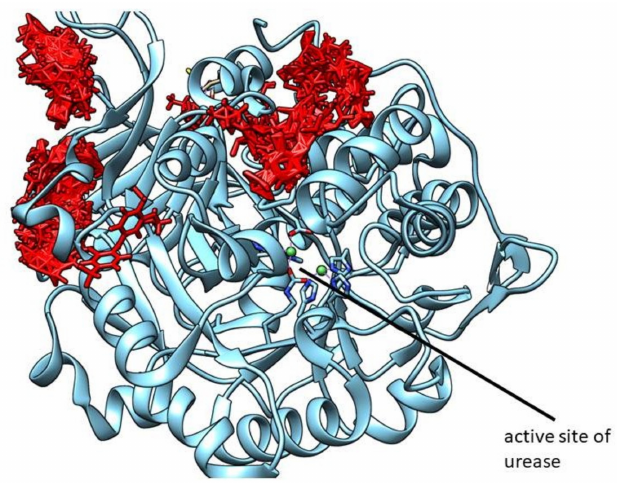
Figure 5. Molecular docking result illustrating the binding modes of oxyfluorfen (red sticks) to urease from Bacillus pasteurii (blue ribbon). Oxyfluorfen does not bind in active cavity of the enzyme, this cavity containing the Ni ions (green